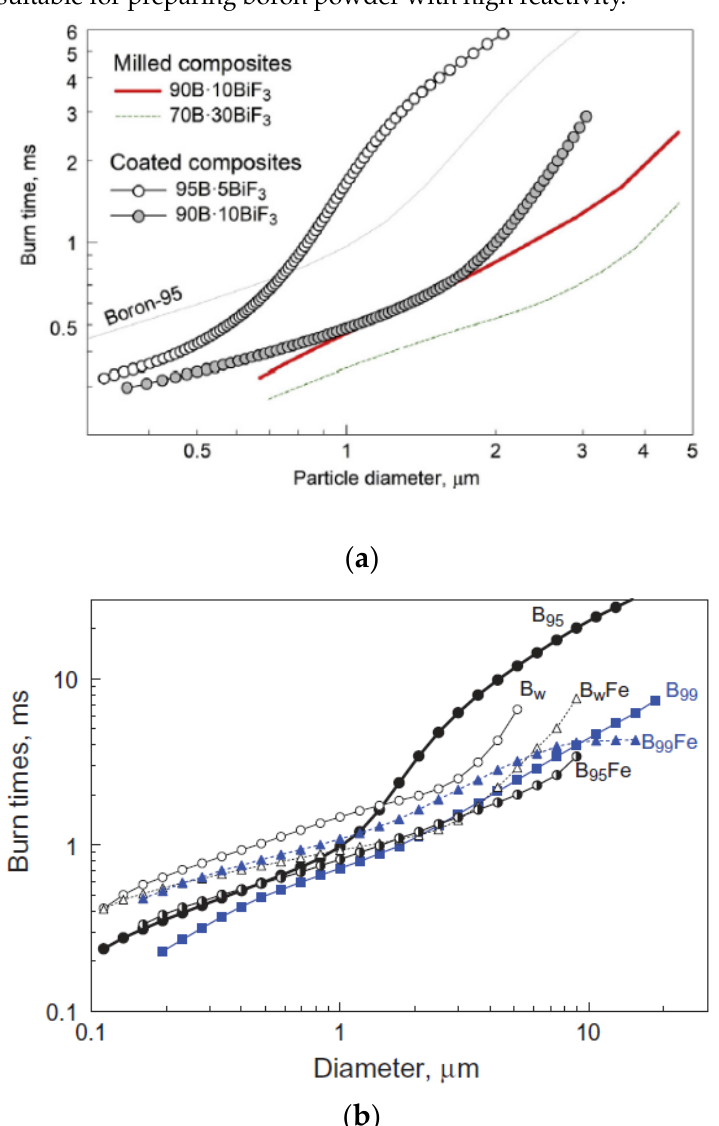
Figure 20. Correlation between the burning time and particle size of ( a ) B@BiF 3 [92]; and ( b ) B@Fe [103].